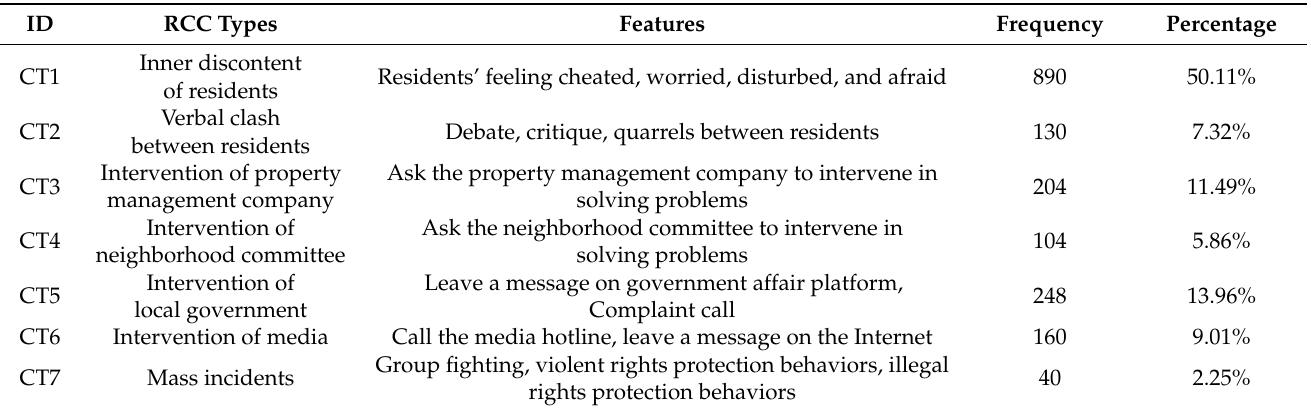
Table 1. The distribution characteristic of RCC